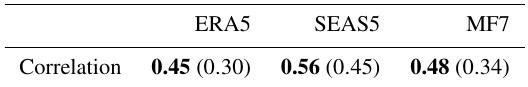
Table 2. Correlation between the HLW and HLE phases: values in bold (parentheses) indicate the correlation using the bias-corrected temperatures (anomalies of temperature) over the east and west SHL